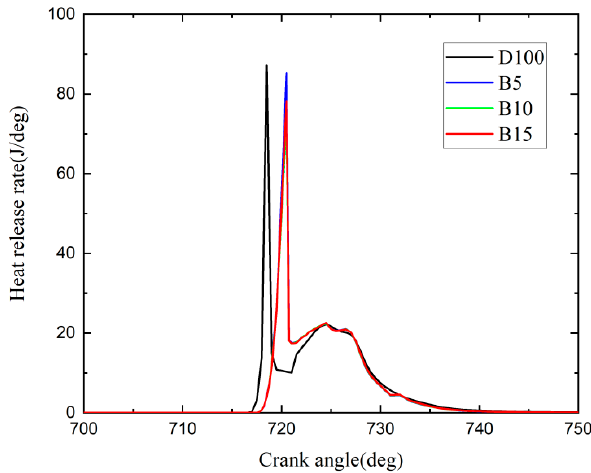
Figure 6. The transient HRR of the four fuels.